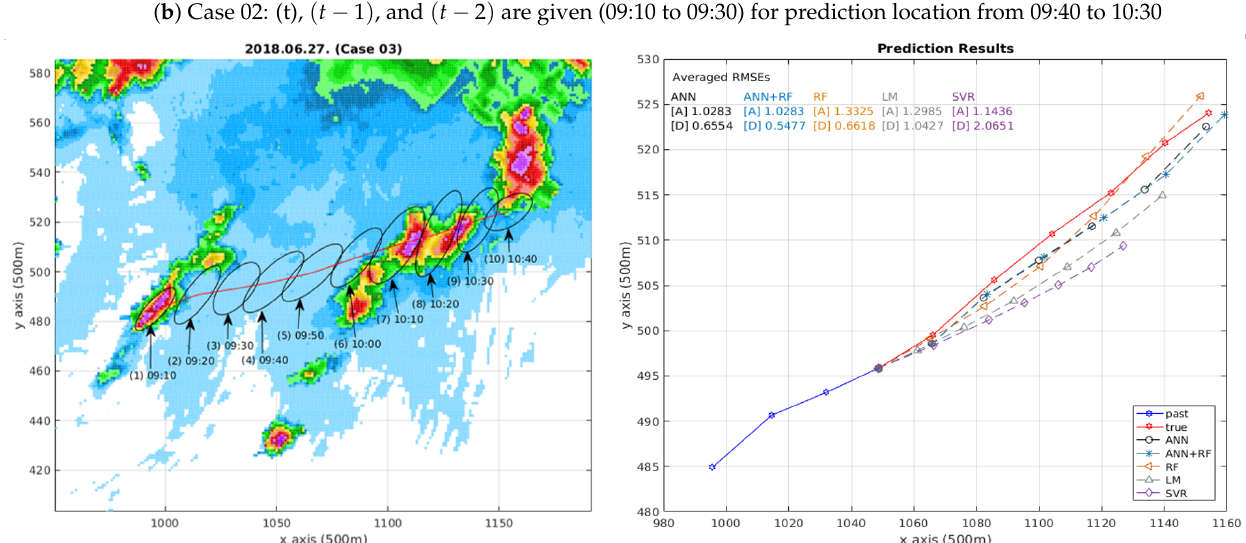
Figure 6. Observed trajectories and prediction results: ( a ) Case 01, ( b ) Case 02, ( c ) Case